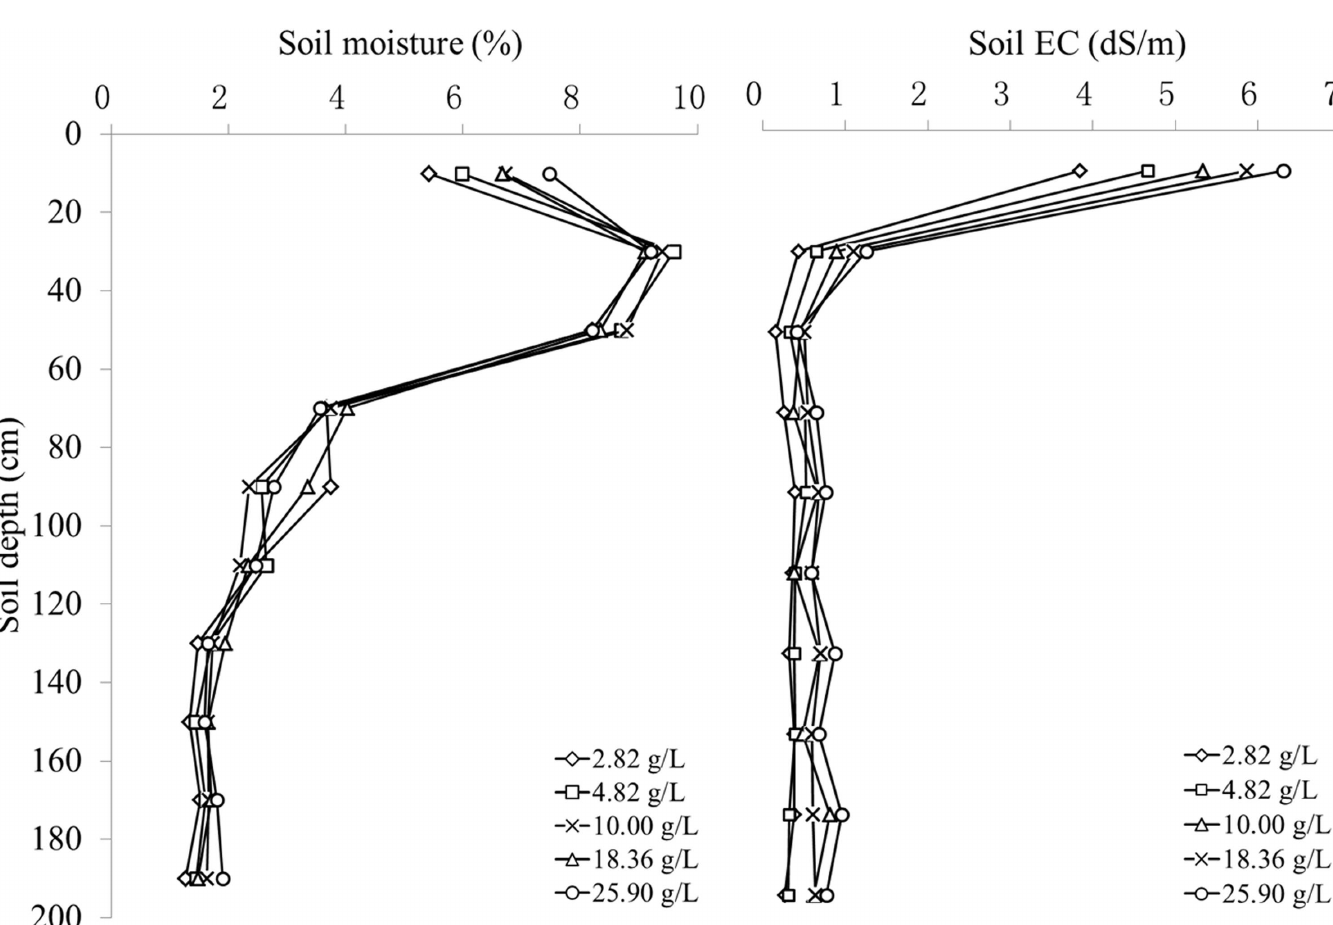
Fig 7. Depth-distribution of soil moisture and salinity at 0–2-m depth irrigated with different salinity